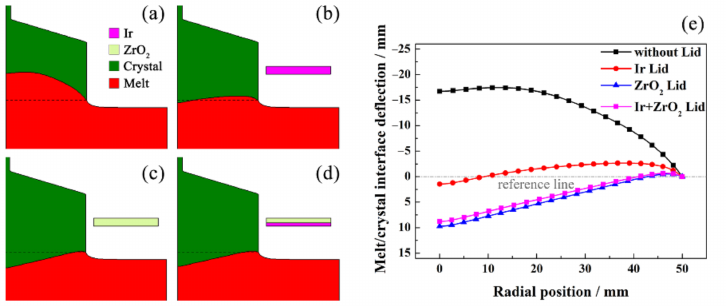
Figure 5. Simulation results of the CZ system ( a ) without an insulation lid, and with an insulation lid made of the following materials: ( b ) Ir, ( c ) ZrO 2 , and ( d ) Ir+ZrO 2 , respectively. ( e ) The corresponding melt/crystal interface shapes in ( a – d ).